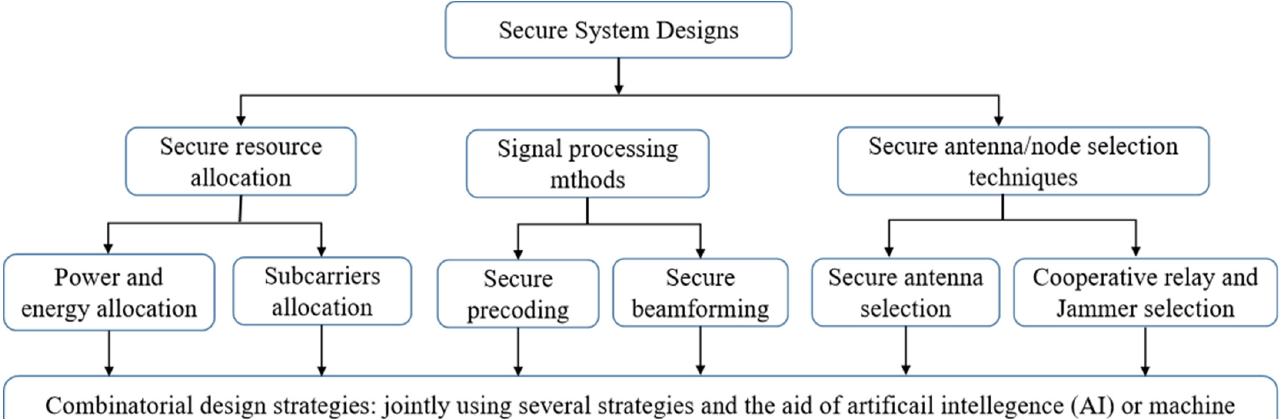
Figure 8. Secure transmission strategies to improve the security and robustness of physical layer designs.